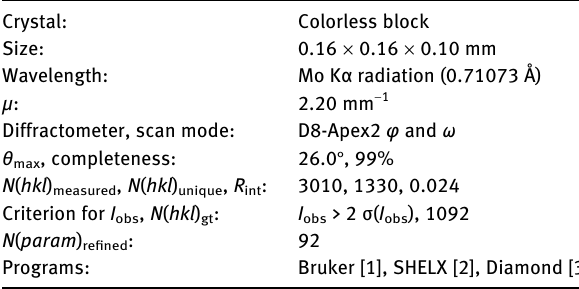
Table  : Data collection and handling. Crystal: